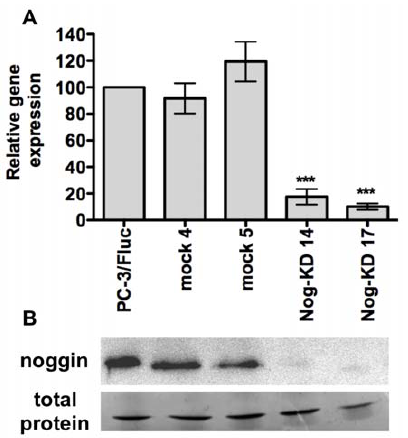
Figure 1. Noggin silencing mediated by shRNA inhibits noggin mRNA and protein expression. A . Noggin mRNA expression in PC- 3/F luc cells, non targeting-vector-transfected clones (mock 4 and 5) and Noggin-KD clones (Nog-KD 14 and 17). The mRNA expression levels ( + / 2 SD) are quantified by real-time RT-PCR and normalized to b -actin as endogenous control; mRNA level in PC-3/F luc cells is set as 100%; the mean of 2 to 3 independent experiments is shown. *** P , 0.001, Nog-KD clones versus PC-3/F luc and mock clones. B . Noggin protein secreted in the conditioned medium (CM) from PC-3/F luc , mock and Nog-KD clones. Equivalent amounts of proteins from concentrated CM